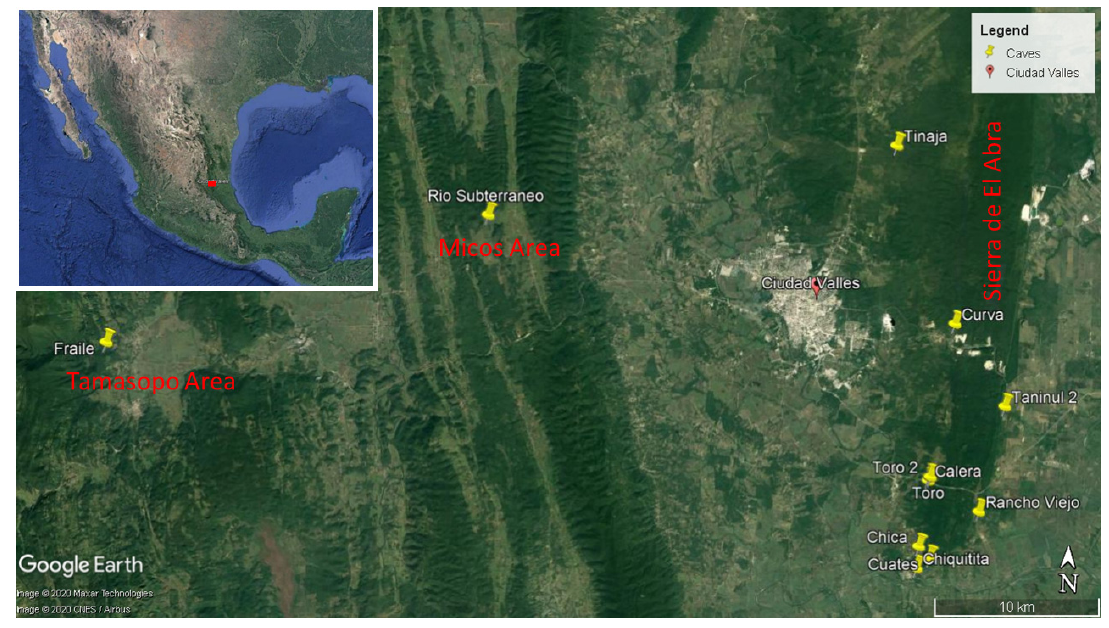
Figure 1. Cave locations. Tinaja and Curva caves are in the central Sierra de El Abra. Taninul, Calera, Toro, Toro #2, Rancho Viejo, Chica, Chiquitita and Cuates are in southern Sierra de El Abra. Río Subterráneo is in the Micos area, still within the El Abra general region. Cueva del Fraile is in the Tamasopo area. Pachón Cave is outside the map boundary, 70 km north of Curva, in the northern Sierra de El Abra. Molino and Caballo Moro are about 110 km north of Curva, in the Sierra de Guatemala. Map showing location of Ciudad Valles, San Luis Potosi. Google Earth, earth.google.com/web/.